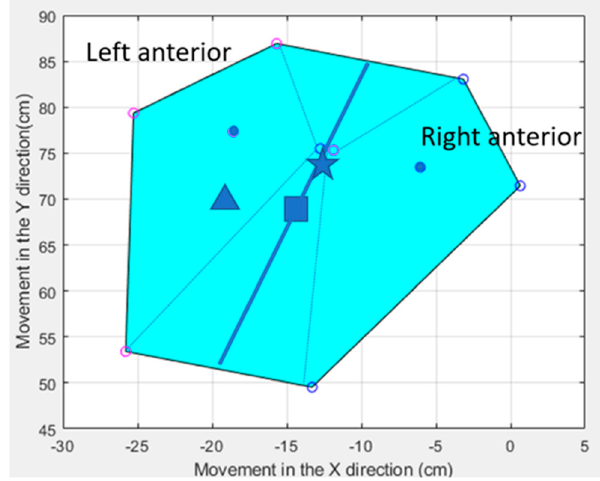
Figure 3. This figure shows two superimposed points in time where P3 ′ s feet have not moved but he has moved his COM over his BOS. The BOS is the shaded area formed by the two feet. The sensor position is the solid circle on each foot; the open circles represent the edges of each foot based on measurements inputted into the code relative to the sensor position. The square is the center of the irregular polygon as calculated by the code. The star is COM 1, and the triangle is COM 2.